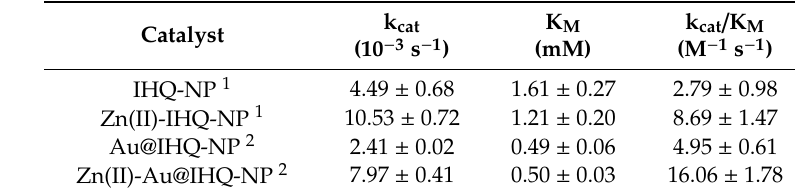
Table 1. Determined kinetic parameters k cat , K M , and k cat /K M of IHQ-NP-catalyzed 4-NPA hydrolysis in absence and presence of Zn(II). Reactions were performed in Tris/HCl buffer pH 8 with 5% acetonitrile at 25 °C 10 µM (Immobilized) IHQ-NP was used and 100 µM ZnCl 2 was added for reactions performed in presence of Zn(II).